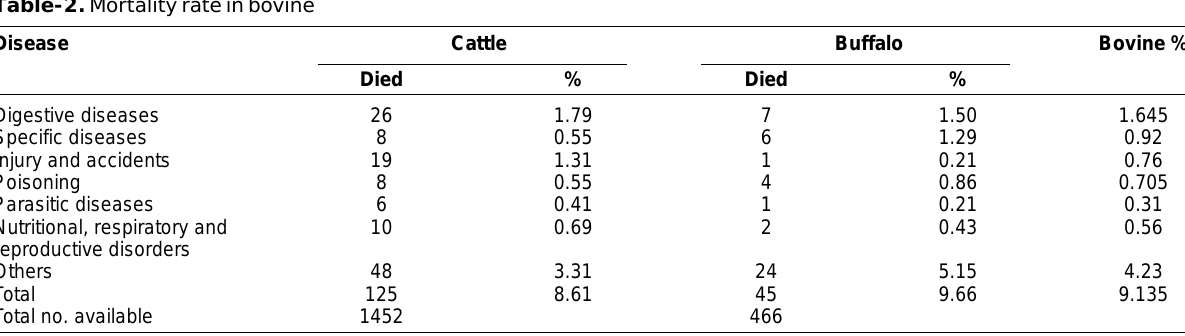
Table-2.1. Age wise mortality rate in bovine Disease